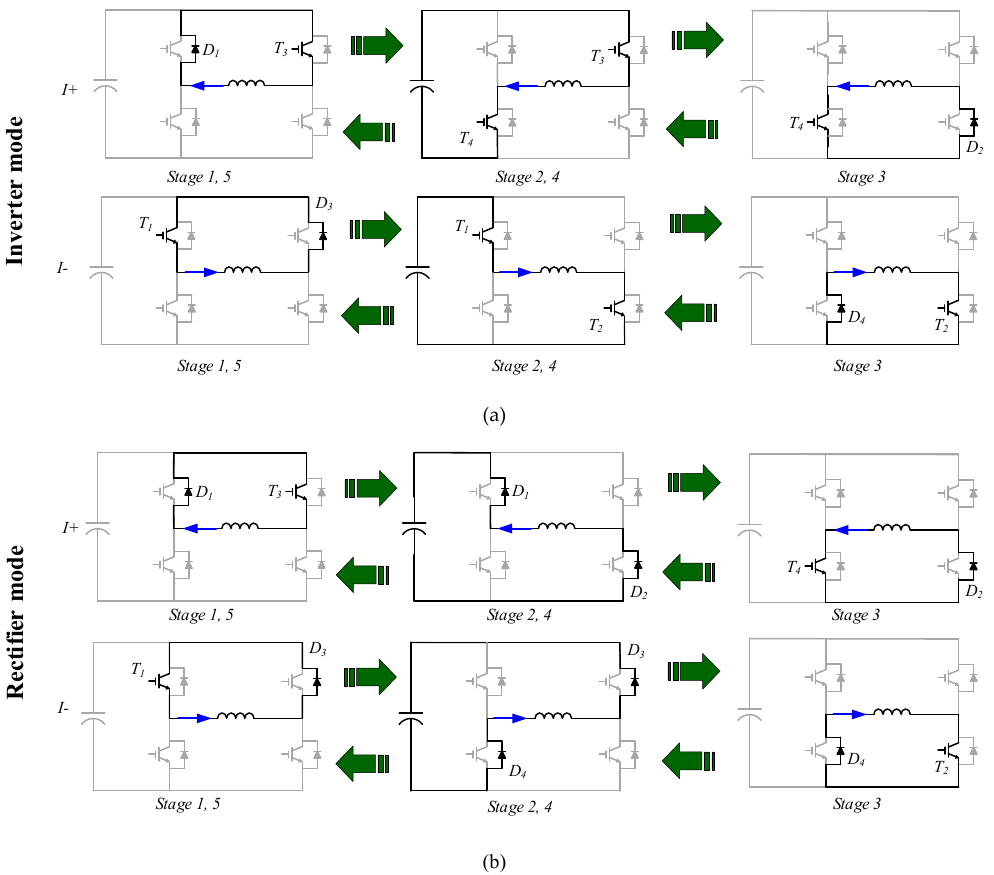
Figure 2. Activated power switches at various operation modes. ( a ) Inverter mode. ( b ) Rectifier mode.